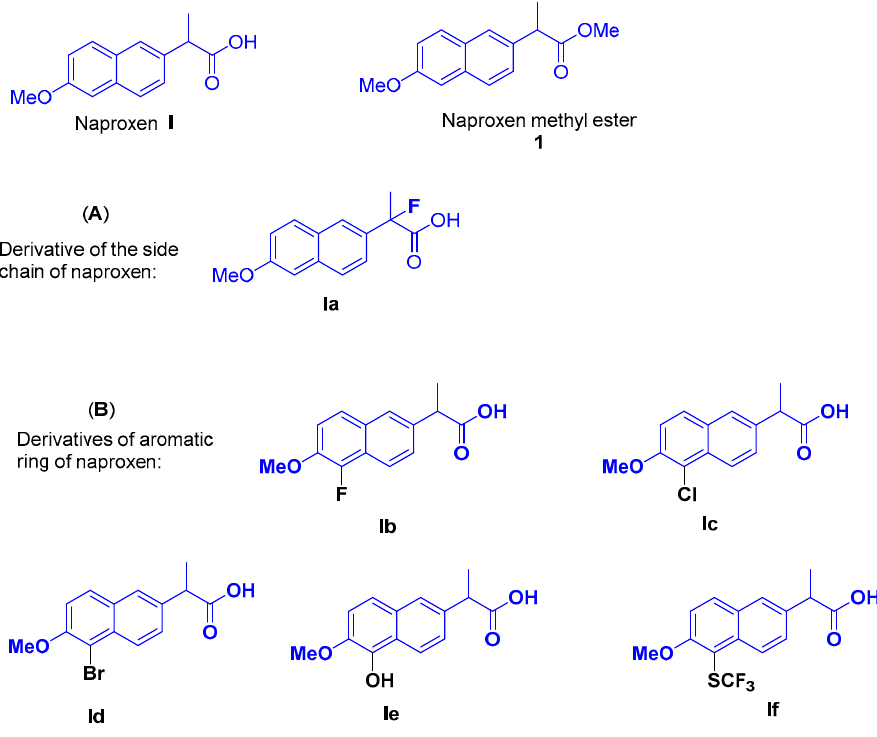
Figure 1. The structure of Naproxen and its typical derivatives: ( A ) the introduction of fluorine atom into the side chain; ( B ) the functionalization of the aromatic ring of